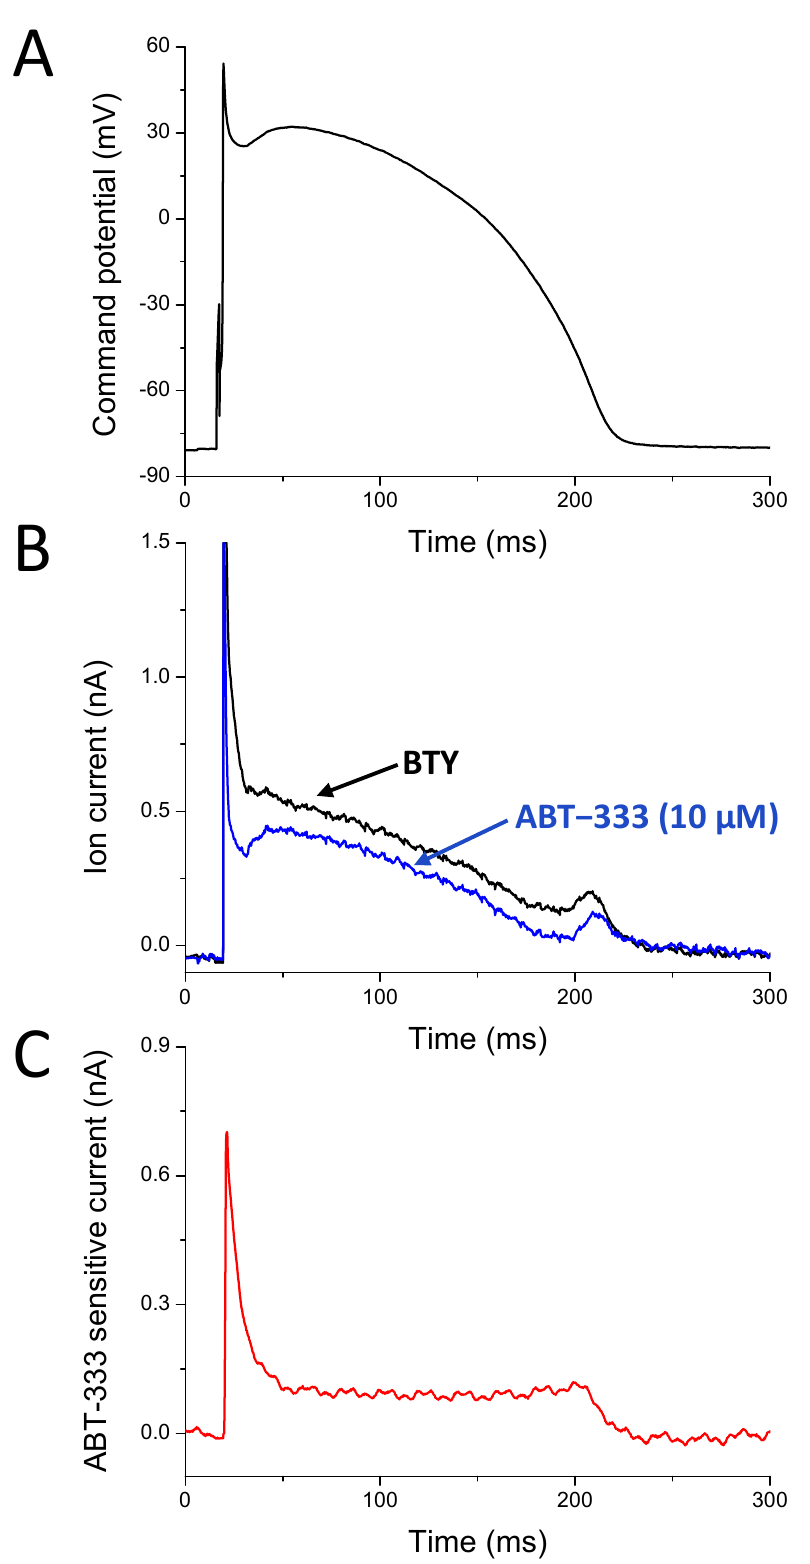
Figure 5. Representative APVC experiment. ( A ) The canonical action potential, which was used as stimulus command. ( B ) Current traces recorded before (black trace) and in the presence of 10 µ M ABT-333 (blue trace). ( C ) The 10 µ M ABT-333-sensitive current calculated by deducting the blue trace from the black one on panel B.